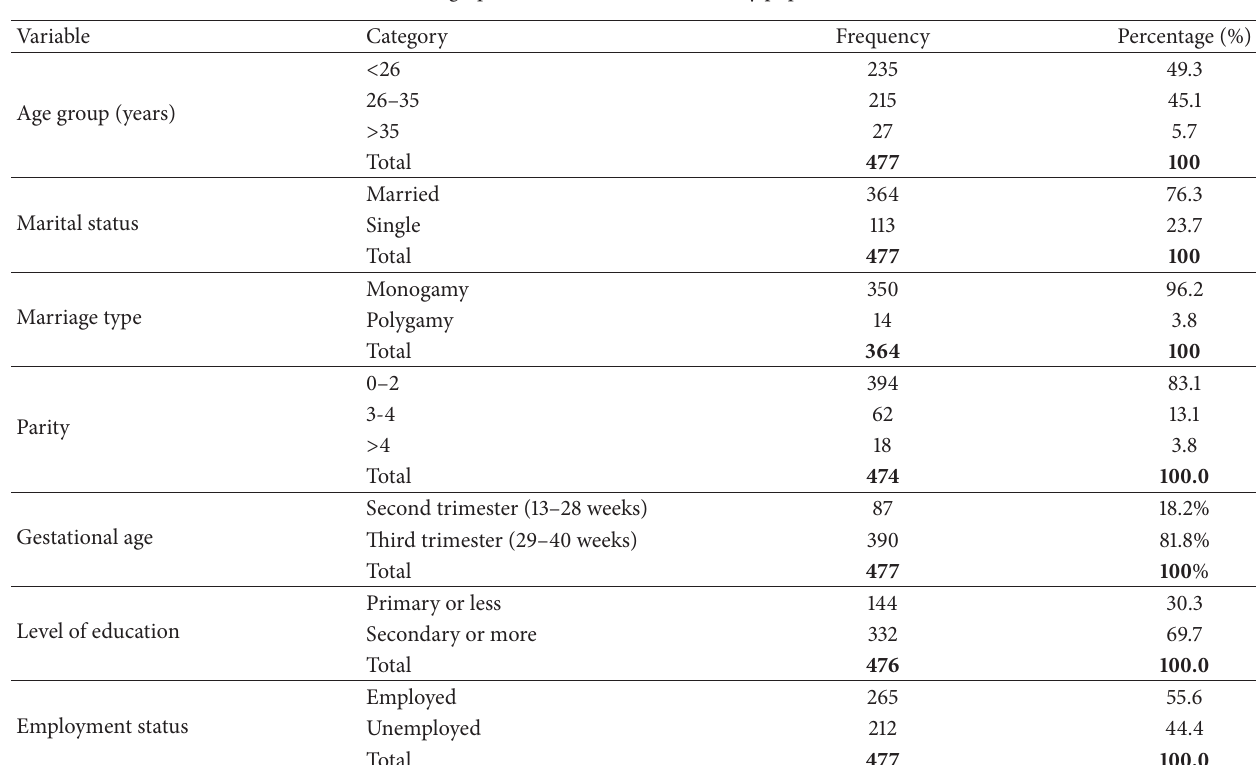
Table 2: Demographic characteristics of the study population ( 𝑛 = 477